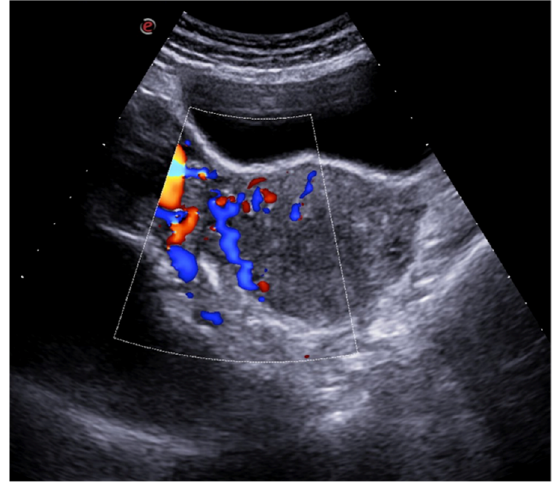
Figure 15. Pelvic congestion syndrome. US axial scan with colour-Doppler mode shows dilated veins in the right adnexa with reversed venous flow after Valsalva maneuver.